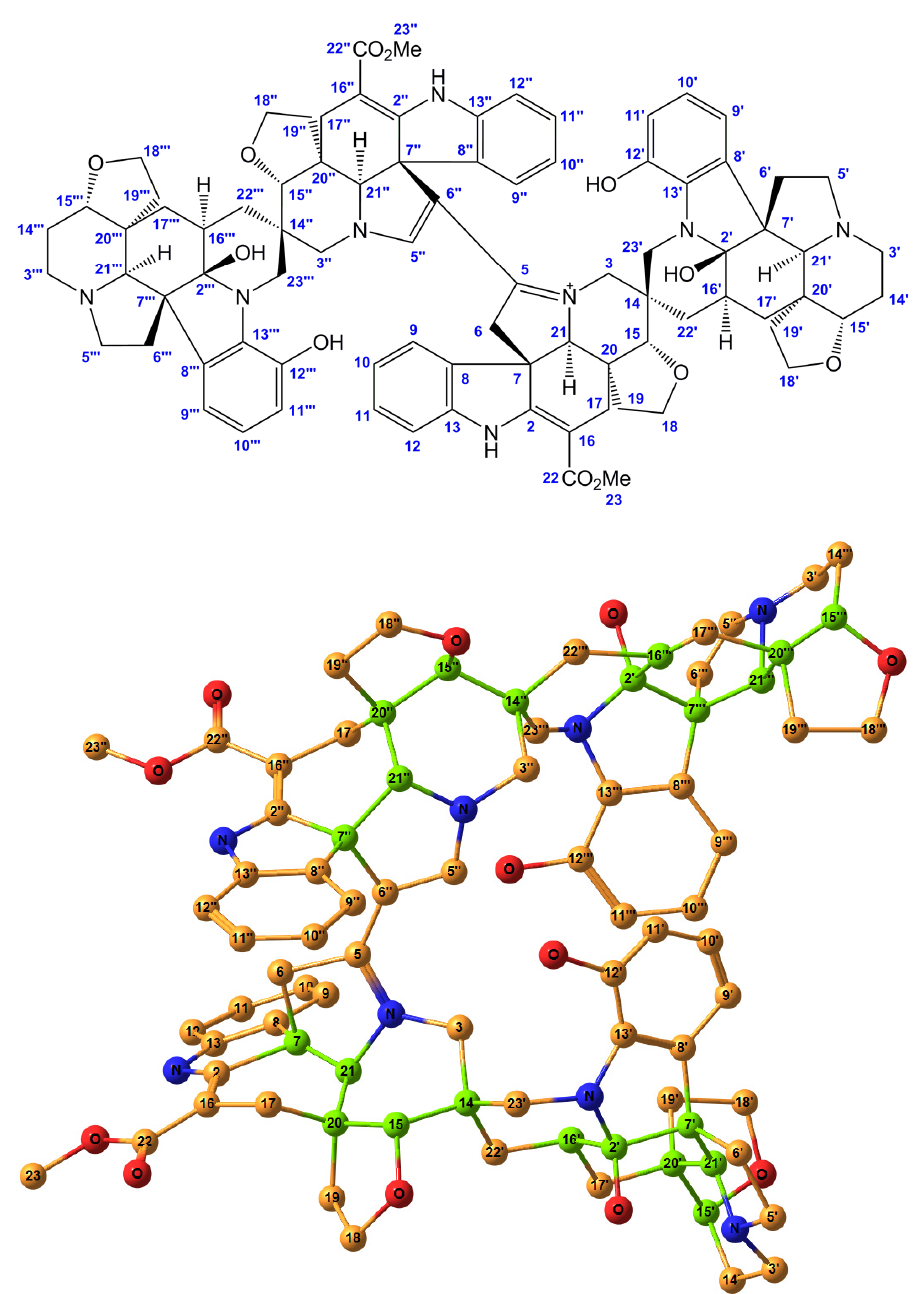
Figure 1. Numbering scheme (top) and the stereochemical structure (bottom) of alasmontamine A; for clarity, hydrogen atoms are not shown. Element colors are as follows: carbons—yellow, nitrogens—blue, and oxygens—red, while all 22 asymmetric carbons are shown in green.